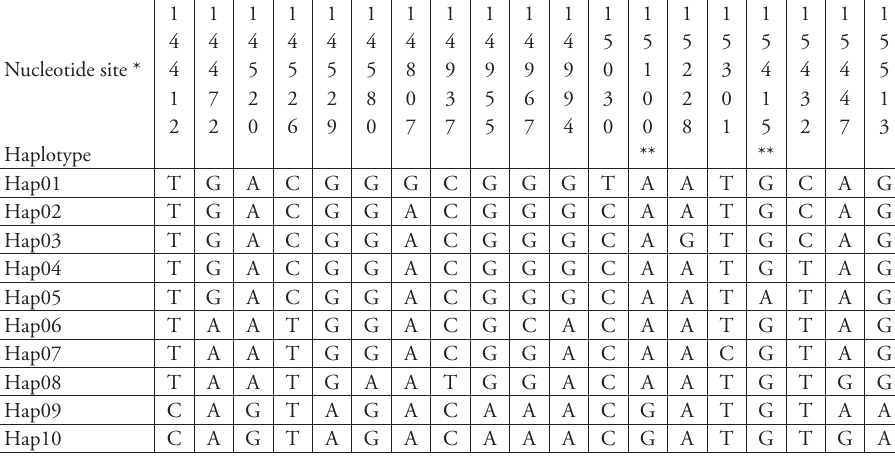
Nucleotide site